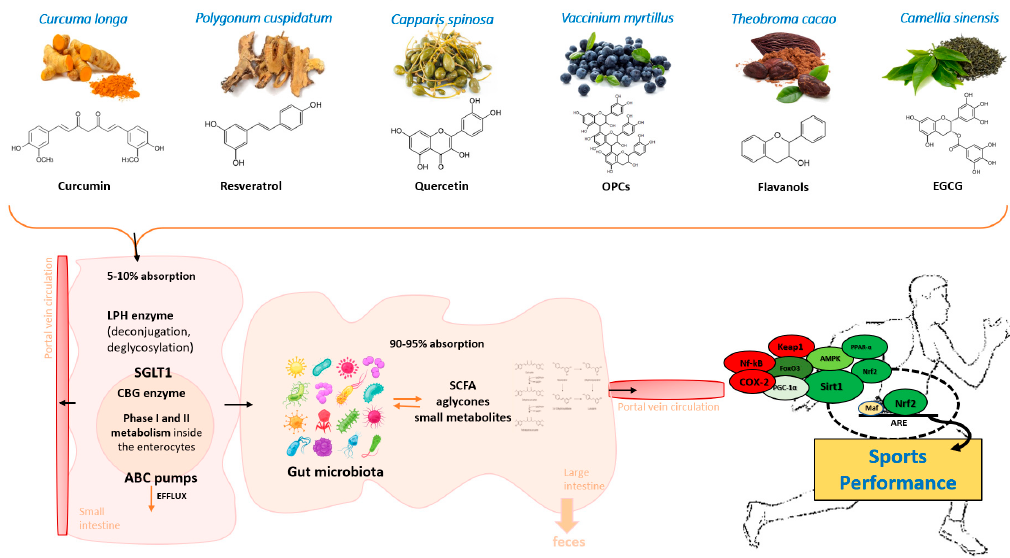
Figure 3. Polyphenol bioavailability and the influence of the gut microbiotaOnce ingested, dietary polyphenols’ metabolism begins in the oral cavity. In saliva, glycosylated flavonoids can be hydrolyzed into aglycones and then converted into smaller compounds, which are subsequently absorbed by the oral epithelium [201]. Once in the stomach, some polyphenols undergo a first reduction in monomeric units [10] and can exert direct protective e ff ects on the gastrointestinal tract [202]. Then, the small intestine is responsible for the absorption of a low amount of polyphenols, mainly after de-conjugation reactions such as de-glycosylation. Aglycones can be absorbed directly in the small intestine, while glycosides, esters, and polymers typically require a first hydroxylation by the intestinal enzymes of the small intestine or by the colon microflora before absorption [203,204]. Unabsorbed polyphenols continue their path in the colon, where the intestinal microbiota continues the metabolic processes. In addition, polyphenols absorbed in the upper part of the gastrointestinal system—metabolized by the liver and excreted in the bile or directly extruded by the e ffl ux pumps of the small intestine enterocytes—reach the colon and experience microbial fermentation or fecal elimination [205].